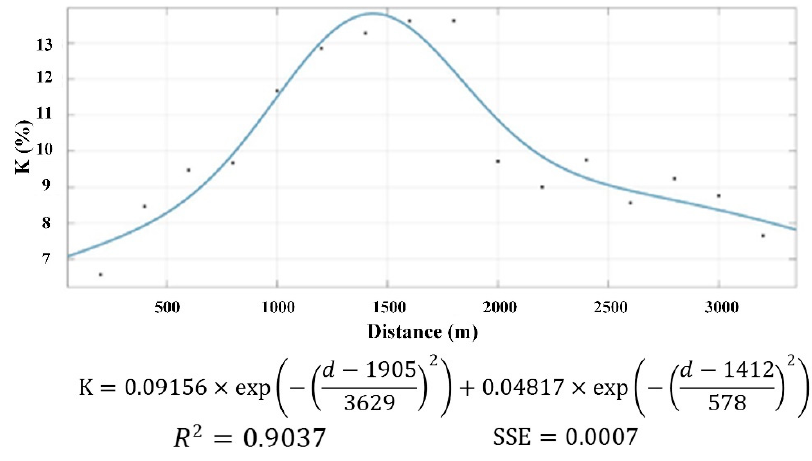
Figure 6. Fitting result between relative change rate and distance to the LRT line. Different intraregional effects were employed to determine the LRT planning influence.